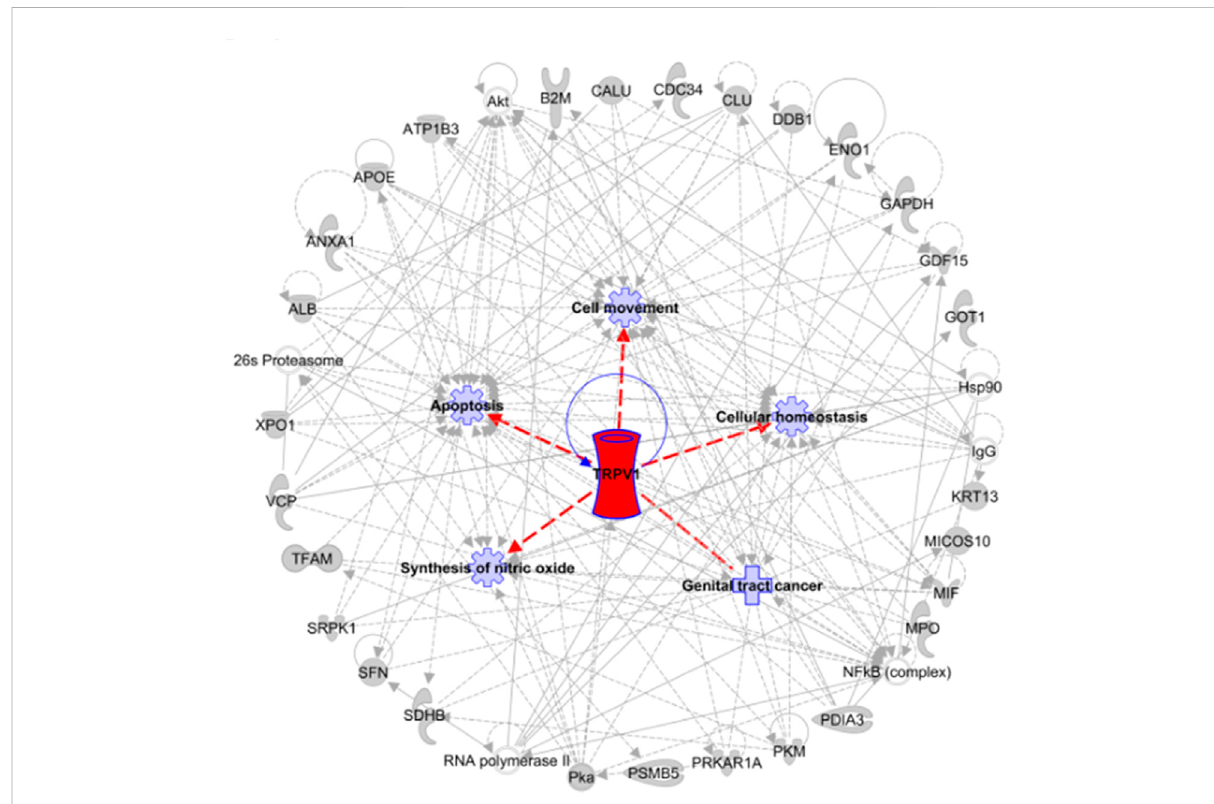
Ingenuity pathway analysis of the top disease and function networks affected by TRPV1 in conjunction with curated DEPs known to be associated with pregnancy outcome post ART a. Network 1: Cell death and survival, cellular compromise, hematological disease, embryonic development, and centered around TRPV1. Lines: interactions and arrowheads: directionality. The network was overlaid with the associated functions and